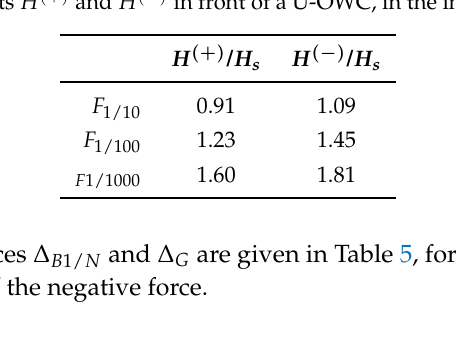
Table 5. Positive force peaks: percentage difference between models and measured extreme horizontal forces on the U-OWC ( ∆ B 1/ N are calculated from H (+) values in Table 4).